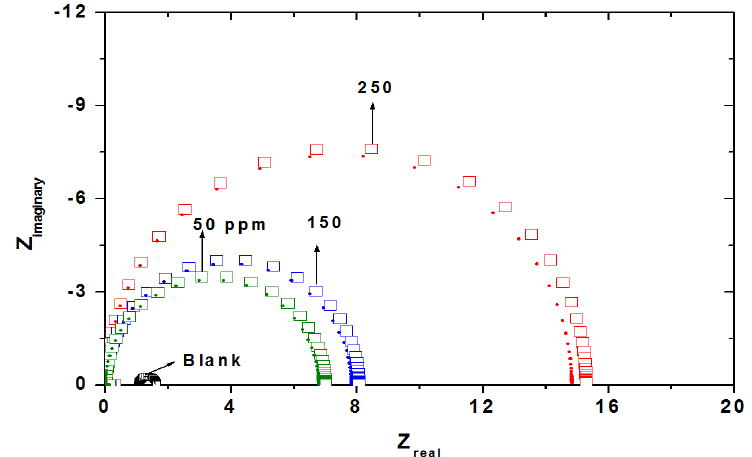
Figure 7. Nyquist plot for steel in 1.0 M HCl without and with different concentrations of inhibitor.